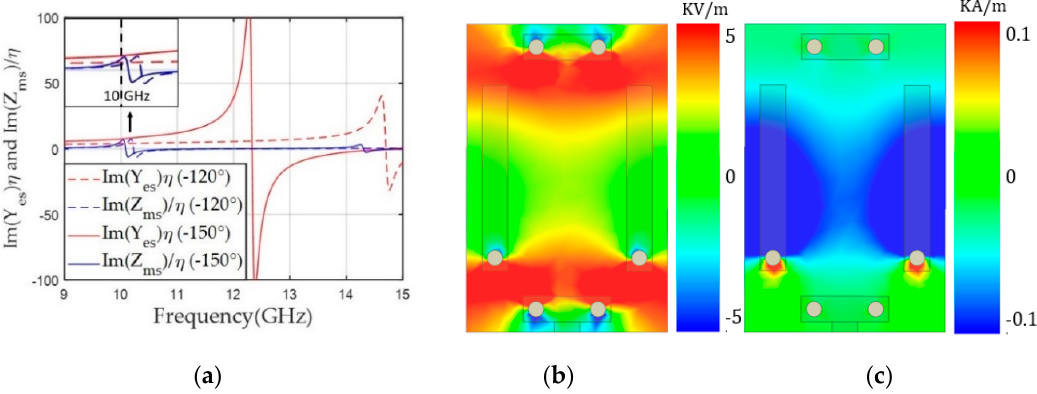
Figure 6. ( a ) Y (cid:2915)(cid:2929) and Z (cid:2923)(cid:2929) values of the unit cell according to frequency for transmission phases of Figure 6. ( a ) Y es and Z ms values of the unit cell according to frequency for transmission phases of − 150 ◦ and − 120 ◦ . ( b ) The y component of the electric field (E − 120 ◦ . ( c ) − 150° and − 120°. ( b ) The y component of the electric field (E y ) for the transmission phase of − 120°. ( c ) y ) for the transmission phase of The x component of the magnetic field (H x ) for − 120 ◦ along the x-y plane in the middle of the unit cell The x component of the magnetic field (H x ) for − 120° along the x-y plane in the middle of the unit cell at 10 at 10 GHz.